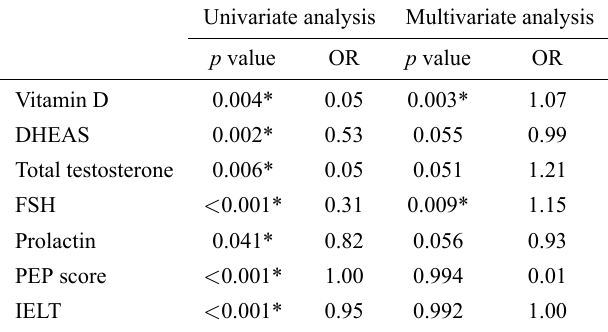
Table 3. Univariate and multivariate analysis results. Univariate analysis Multivariate